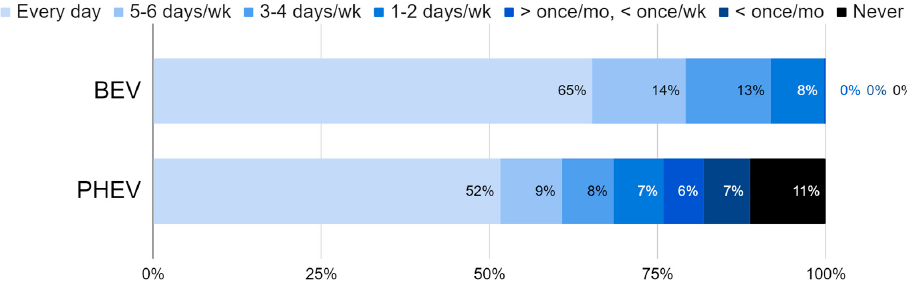
Figure 9. Charging frequency for BEV and PHEV TNC drivers.